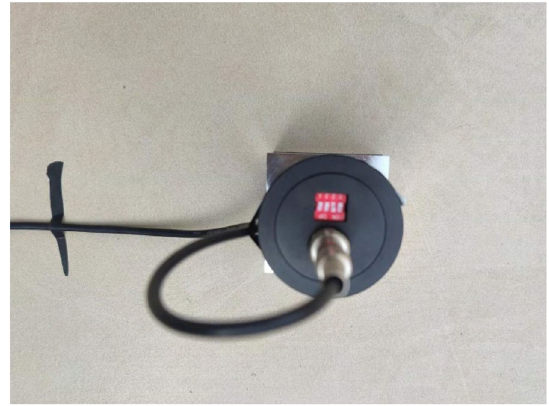
Fig. 4 The vertical